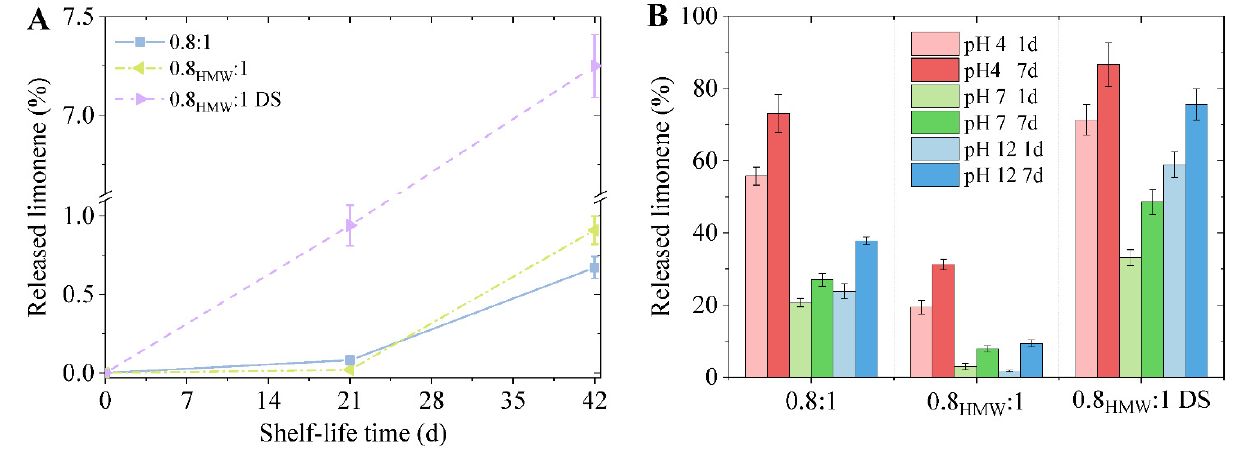
Figure 8. ( A ) shelf-life stability; ( B ) pH stability of LMCs samples.